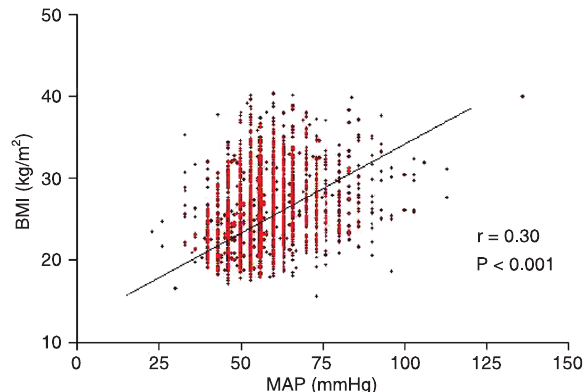
Figure 1. Correlation between body mass index (BMI) and mean arterial pressure